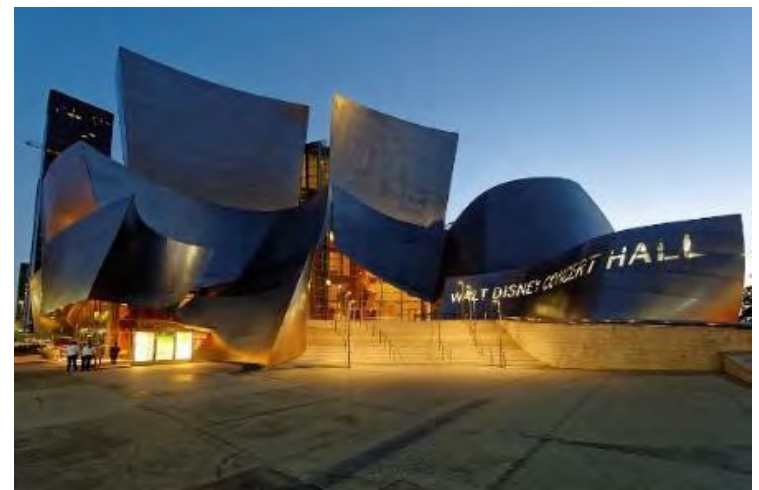
Figure 1. The Walt Disney Concert Hall in